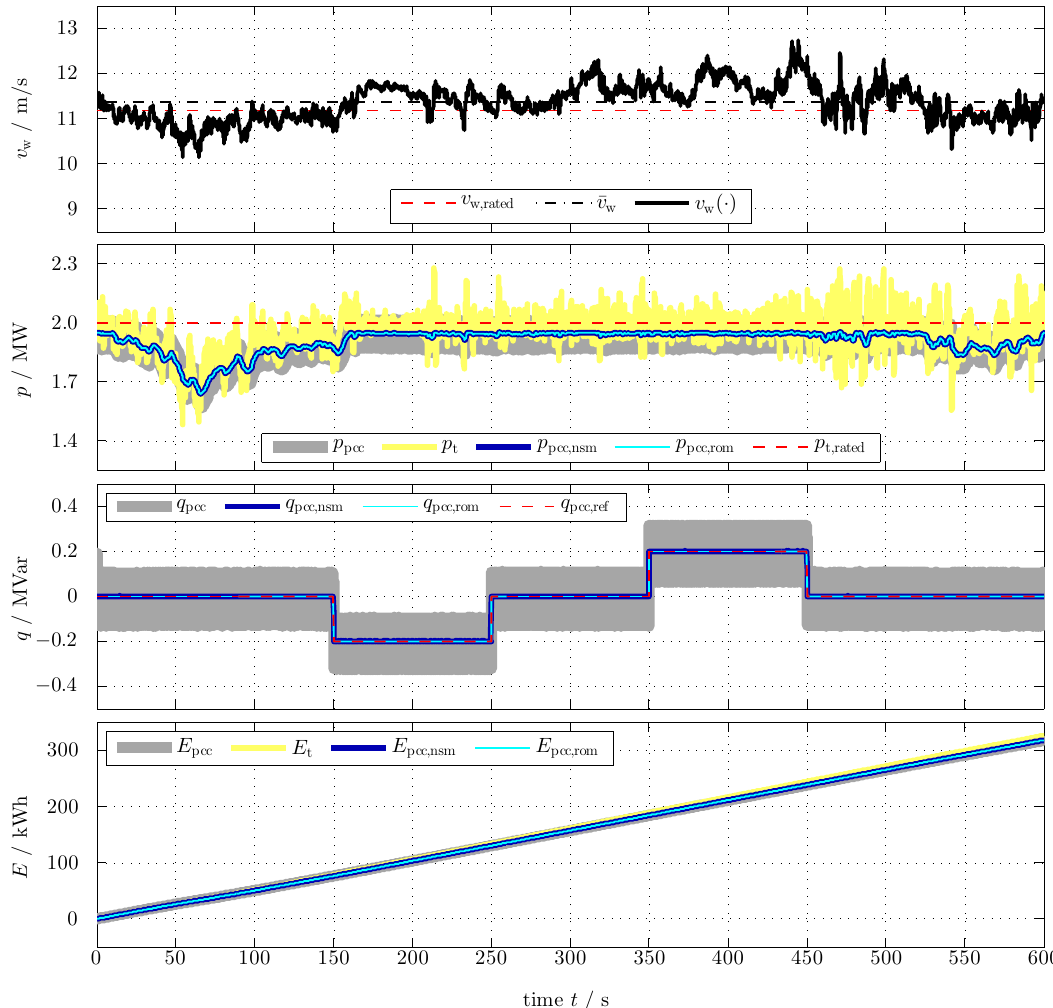
Figure 11. Comparison of active and reactive powers, and produced